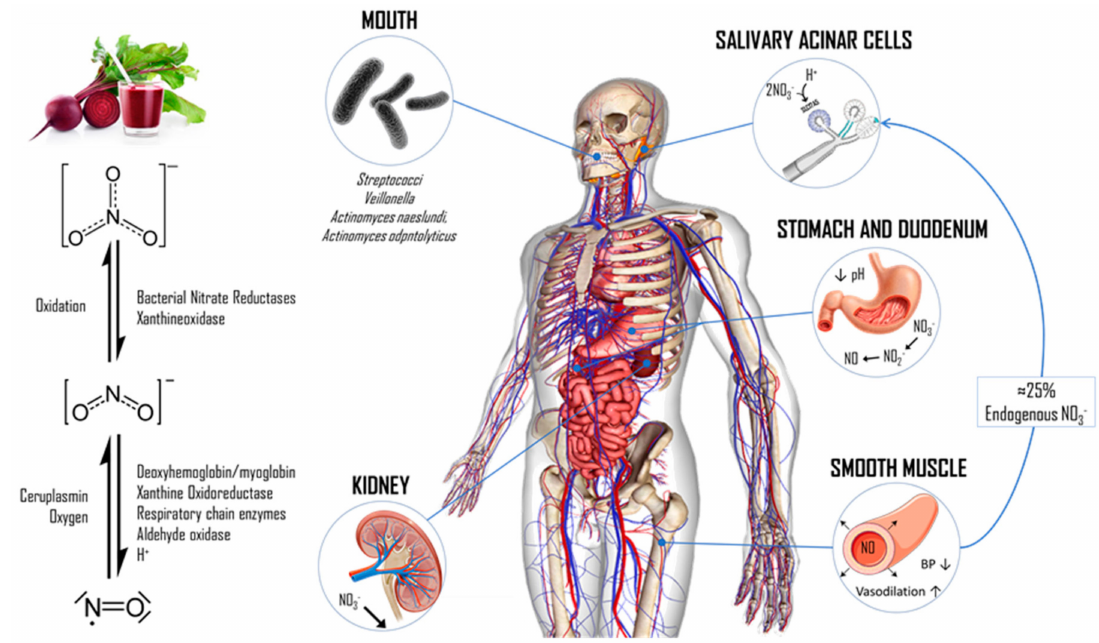
Figure 1. The nitrate/nitrite/nitric oxide (NO 3 − /NO 2 − /NO) pathway after beetroot juice (BRJ) ingestion. Next to BRJ ingestion, oral microbiota on the posterior surface of the tongue is able to reduce NO 3 − to NO 2 − by means of their enzymatic machinery. The strict anaerobes Veillonella atypical and Veillonella dispar are the most important NO 3 − reducers; however, Actinomyces , Rothia , Prevotella , Neisseria , and Haermophilus are also present on the oral cavity. Even though this non-enzymatic reduction process continues in stomach, where more NO 2 − and NO are produced due to the acid environment, a considerable amount of NO 3 − from blood ( ≈ 25%) is taken up by an electrogenic 2NO 3 − /H + symporter called SLC17A5 (also known as sialin, UniProt ID: Q9NRA2) in the salivary gland acinar cells [14]. Both dietary and saliva NO 3 − , and its reduced forms NO 2 − and NO, enter directly to systemic circulation after the absorption process in the stomach and intestine. either enzymatic or non-enzymatic mechanisms (such as xanthine oxidoreductase, respiratory chain enzymes, aldehyde oxidase, methemoglobin formation, protons, etc.), especially under physiologic